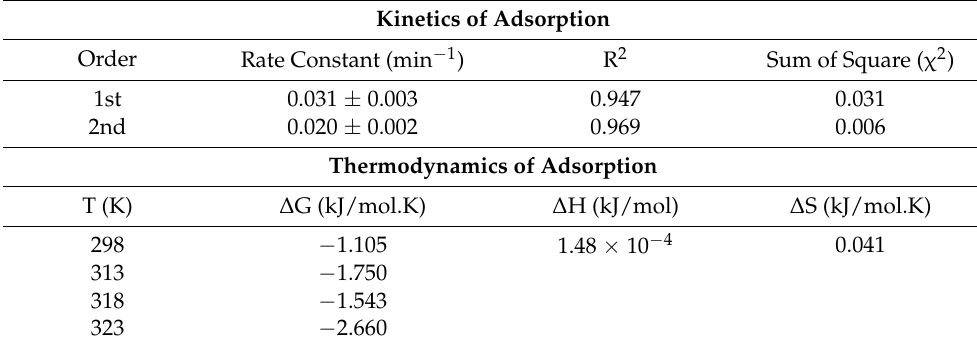
Table 4. The kinetics of adsorption and thermodynamics of adsorption.